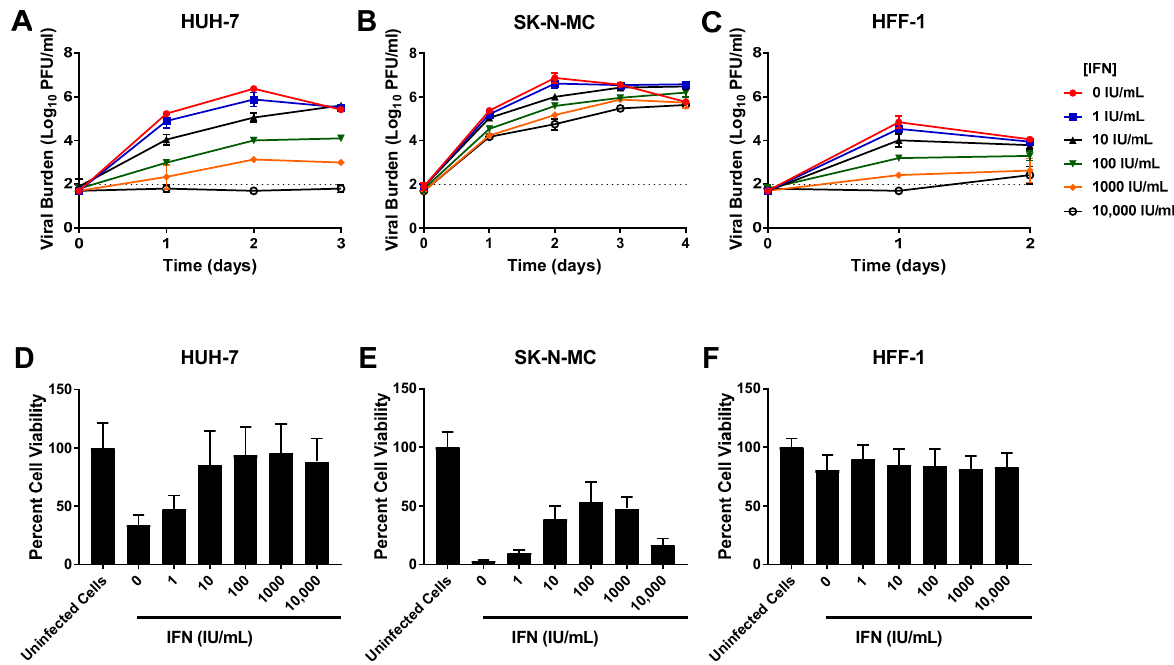
Figure 2. Antiviral activity of interferon-alpha (IFN) against dengue virus (DENV) in HUH-7, SK-N-MC, and HFF-1 cells ( A – C ). HUH-7 ( A ) cells were infected at a multiplicity of infection (MOI) of 0.01, and SK-N-MC ( B ) and HFF-1 ( C ) cells were infected at an MOI of 0.1. Infected cells were treated with different concentrations of IFN. Viral burden was quantified via plaque assay on Vero cells, and reported as log 10 plaque forming units per mL (PFU/mL). Data points represent the mean of three independent samples, and error bars correspond to one standard deviation. The dashed line signifies the assay limit of detection. ( D – F ) Effect of IFN treatment on cell viability of DENV-infected HUH-7 ( D ), SK-N-MC ( E ), and HFF-1 ( F ) cells. HUH-7, SK-N-MC, and HFF-1 cells were infected with DENV at MOIs of 0.01, 0.1, and 1, respectively, then treated with different concentrations of IFN. Cell viability was measured after three days with the commercially available WST-1 assay according to manufacturer specifications. Cell viability is reported as percent cell viability relative to an untreated, uninfected control. Columns represent the mean of 6 independent samples, error bars represent one standard